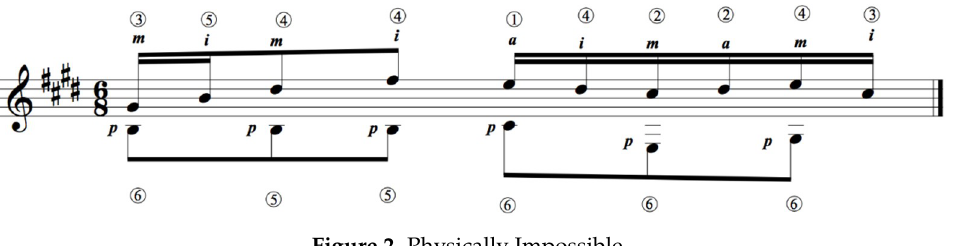
Figure 2. Physically Impossible.